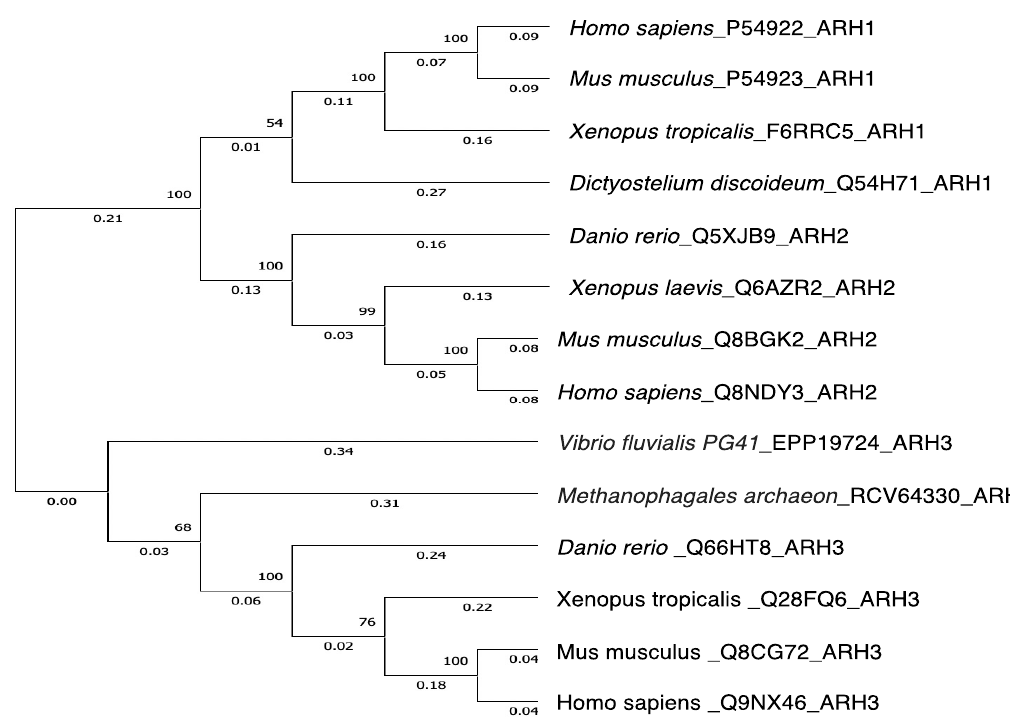
Figure 3. Phylogenetic trees showing genetic relationships of ARH1, ARH2 and ARH3.The tree was constructed by the UPGMA in the Evolutionary Genetics Analysis X (MEGAX) program (https://www.megasoftware.net/, accessed on 13 October 2022). The evolutionary distance was computed using p-distance method by the MEGAX [106,107] . Reference sequences are indicated by species_accession number_protein name. The bootstrap values (%) of 500 replications are shown at each internal node. Genetic variations between human ARH1 and human ARH2 or human ARH3 were 0.57 and 0.82, respectively. Amino acid sequences were obtained from UniProt (https://www.uniprot.org/, accessed on 13 October 2022).